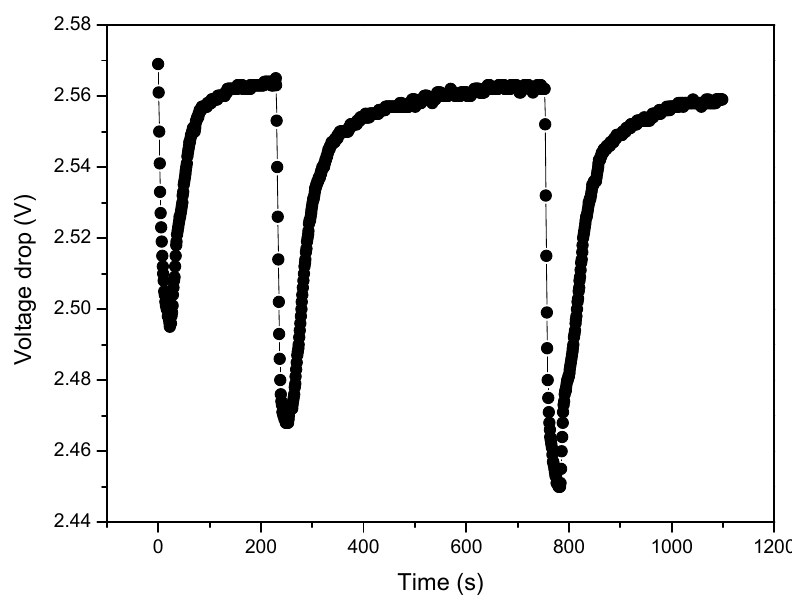
Figure 5. Human-breathing pattern (exhalations) obtained by the voltage drop technique. The I–V characteristics of the square-wave voltage source are shown in Figure 6a. This curve was obtained by applying to the generator a gradually increasing pure resistive load of a precisely known value (tolerance of resistors: 1%), and measuring the output voltage ± and the absorbed current by true-RMS digital voltmeter and digital ammeter, respectively.